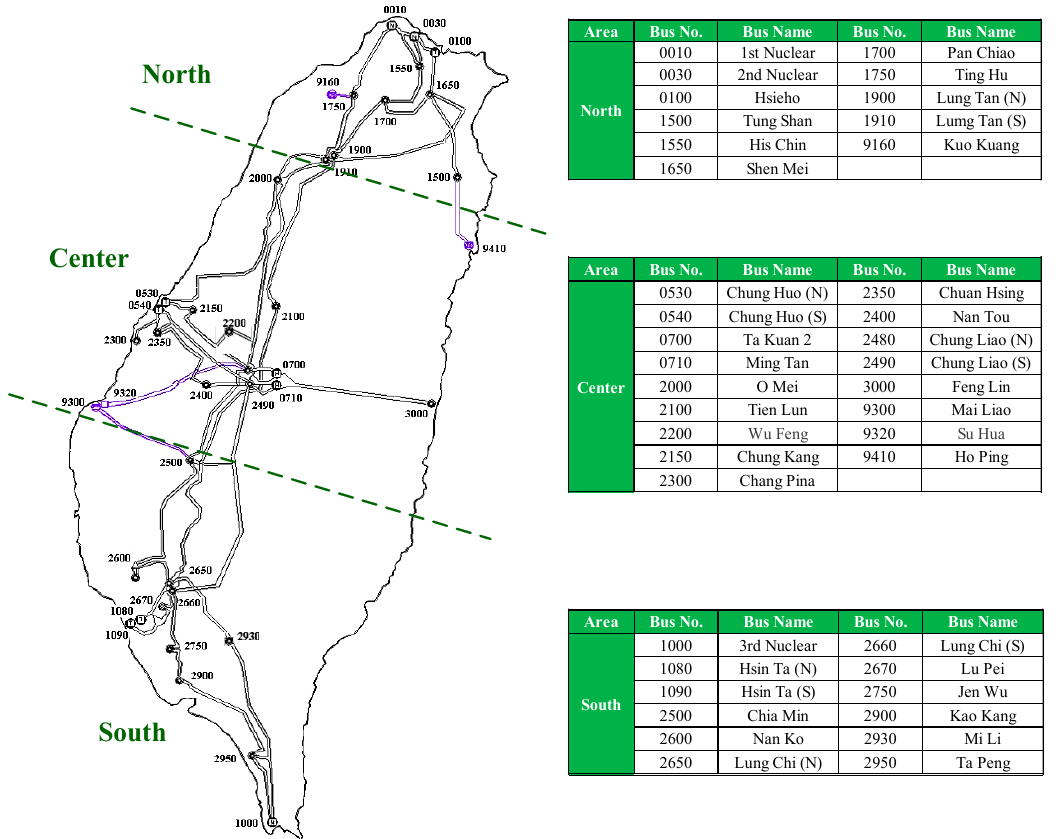
Figure 11. Simplified diagram of Taipower system.